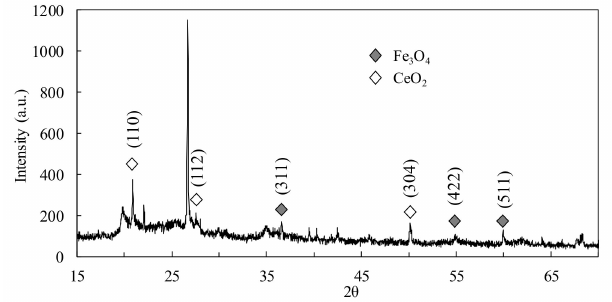
Figure 4. XRD patterns of Fe-Ce / DIA.